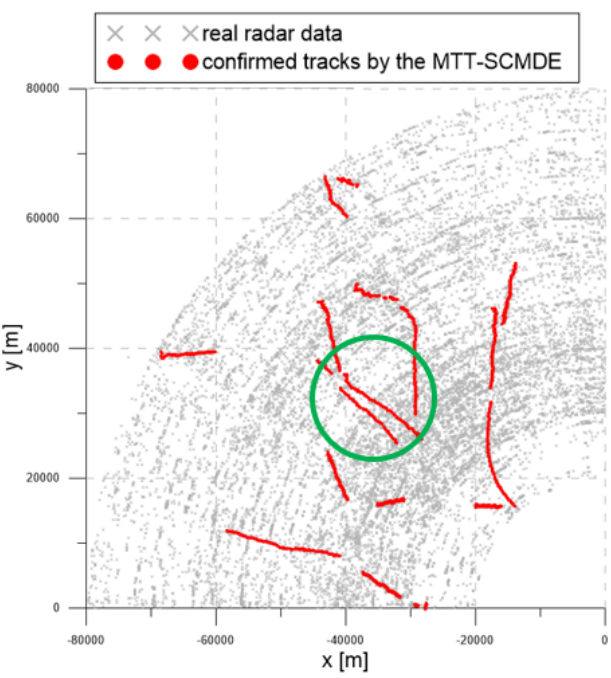
Figure 19. The trajectories of the confirmed tracks by using the proposed